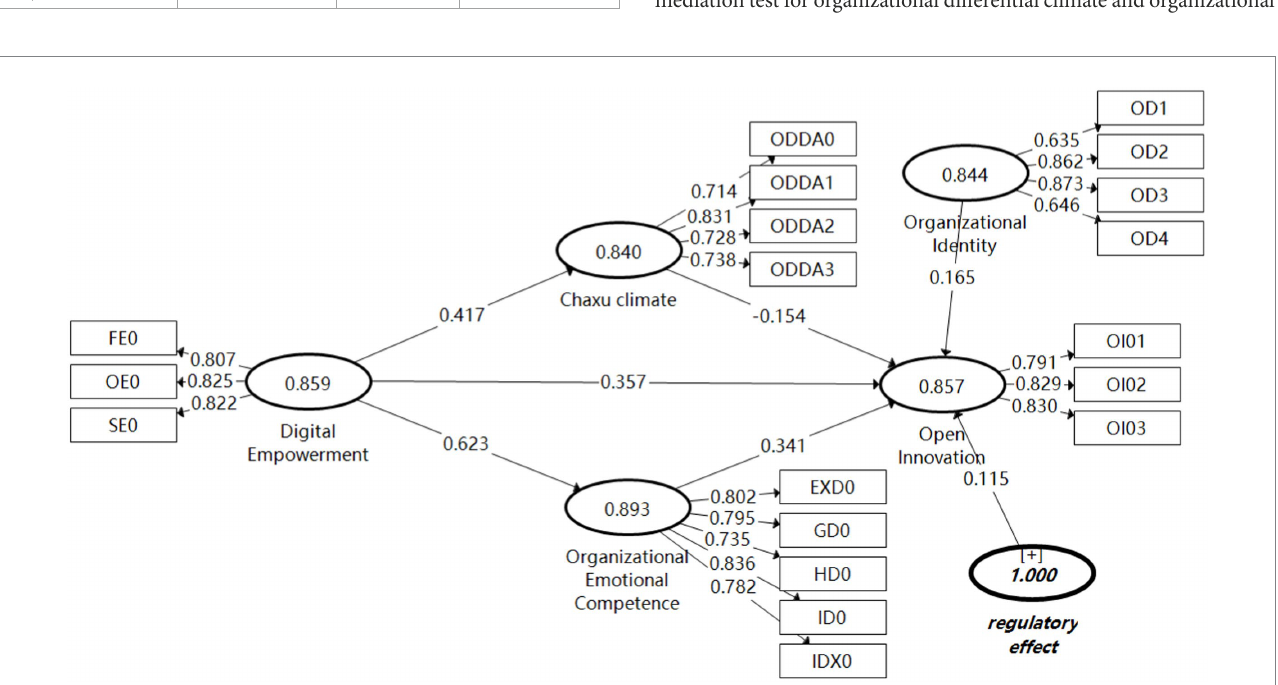
FIGURE 3 Path coefficient diagram.